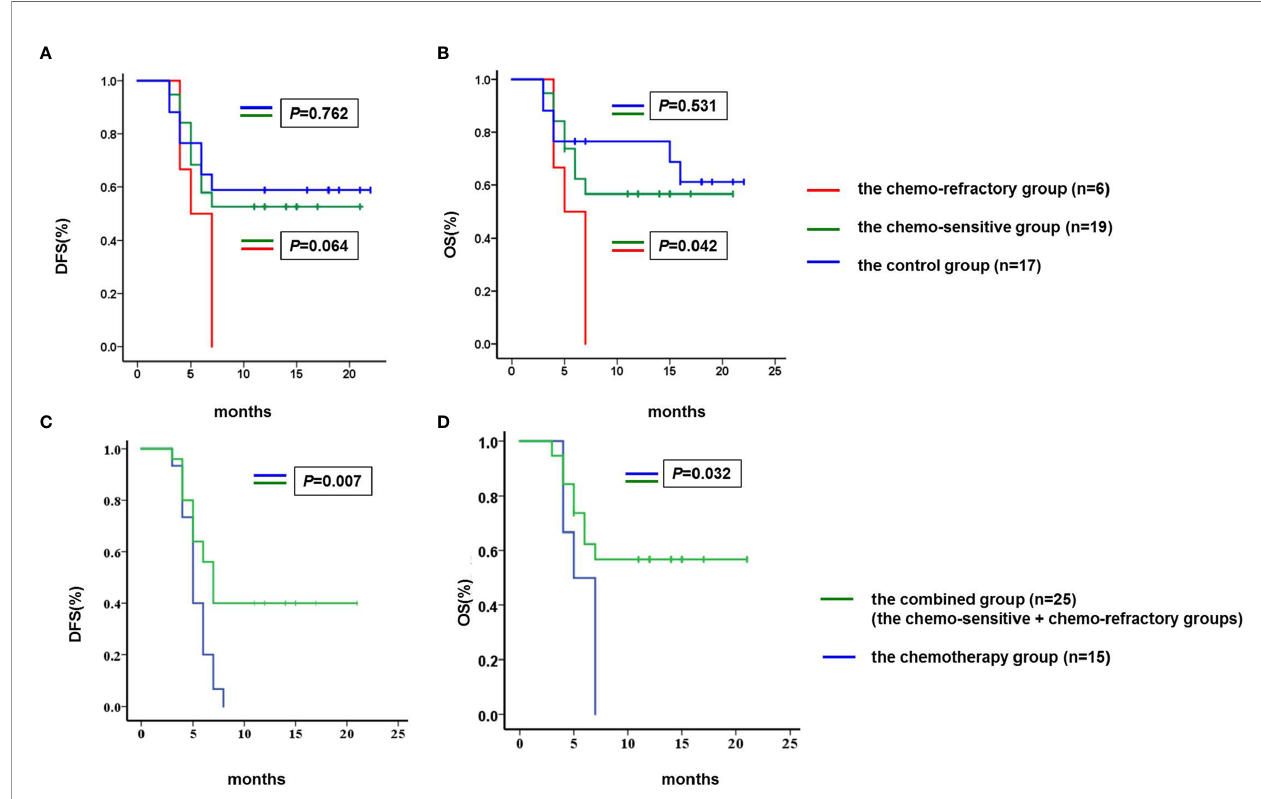
FIGURE 6 | Comparison of DFS and OS. (A) The median DFS of the chemo-sensitive and control groups was not achieved, and the median DFS of the chemo- refractory group was 5.0 months (95% con fi dence interval 3.2 – 6.8). No differences were observed in DFS between the chemo-sensitive and chemo-refractory groups ( P = 0.064), neither between the chemo-sensitive and control groups ( P = 0.762). (B) The median OS of the chemo-sensitive and control groups was not achieved, and the median OS of the chemo-refractory group was 5.0 months (95% con fi dence interval 3.2 – 6.8). The median OS of the chemo-sensitive group was longer than that of the chemo-refractory group ( P = 0.042), no differences were observed in OS between the chemo-sensitive and control groups ( P = 0.531). (C) The median DFS of the chemotherapy and combined groups was 5 months (95% con fi dence interval 4.3 – 5.7) and 7 months (95% con fi dence interval 5.8 – 8.2), respectively ( P = 0.007). (D) The median OS of the chemotherapy and combined groups was 5 months (95% con fi dence interval 4.3 – 5.7) and 7 months (95% con fi dence interval 5.8 – 8.2), respectively ( P = 0.032). DFS and OS were estimated using the Kaplan – Meier method and were compared using the log-rank test. DFS, disease free survival; OS, overall